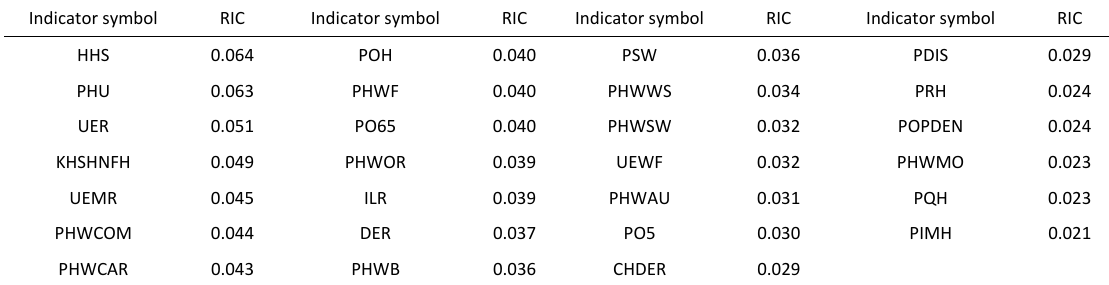
Table 3. Relational importance of indicators Table 3: Relational importance of